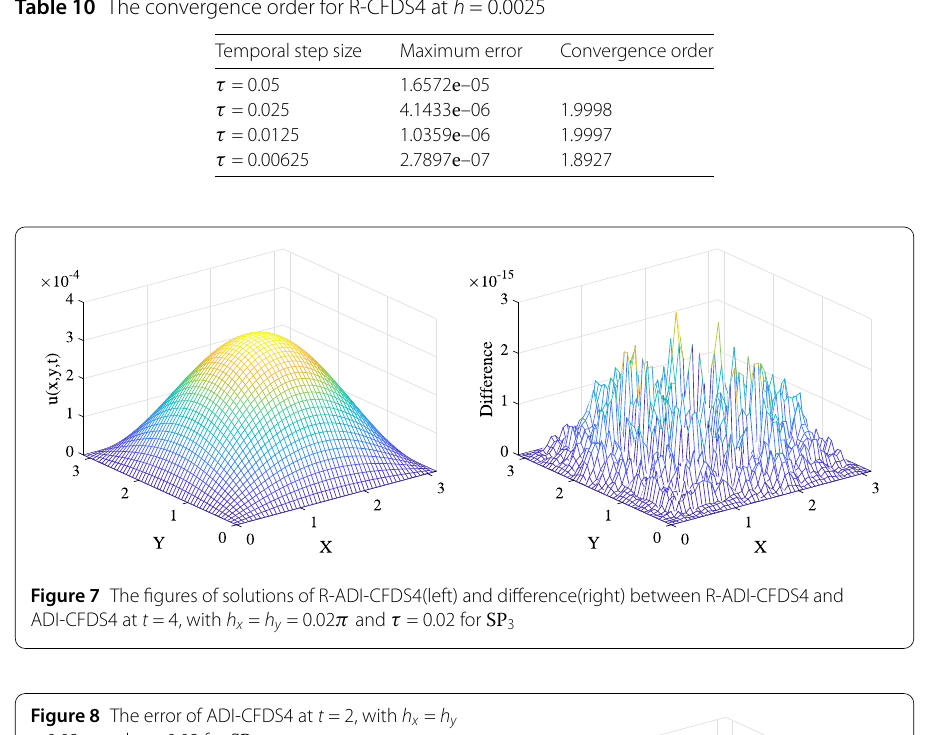
Figure 8 The error of ADI-CFDS4 at t = 2, with h x = h y = 0.02 π and τ = 0.02 for SP